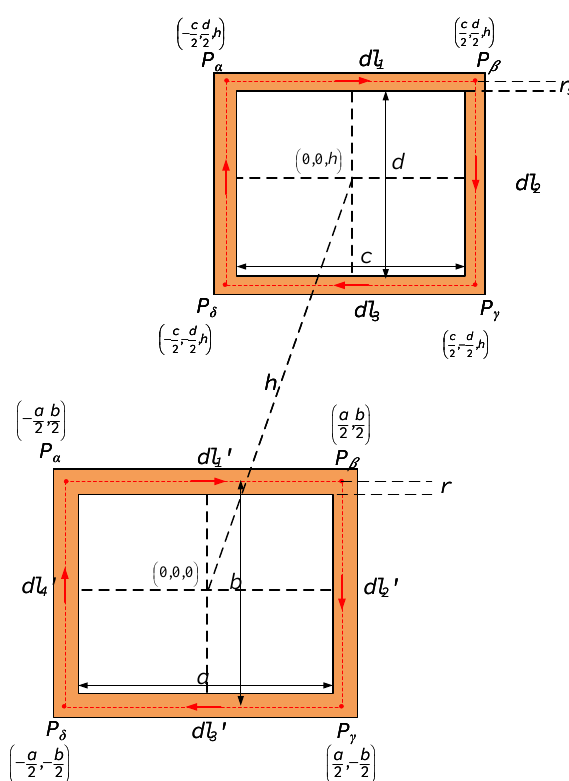
Figure 4. Mutual inductance between a general primary single turn and a secondary single turn. The length and breadth of the primary are ( a , b ) , while those of the secondary are ( c , d ) . The vertical displacement between the primary and secondary is h